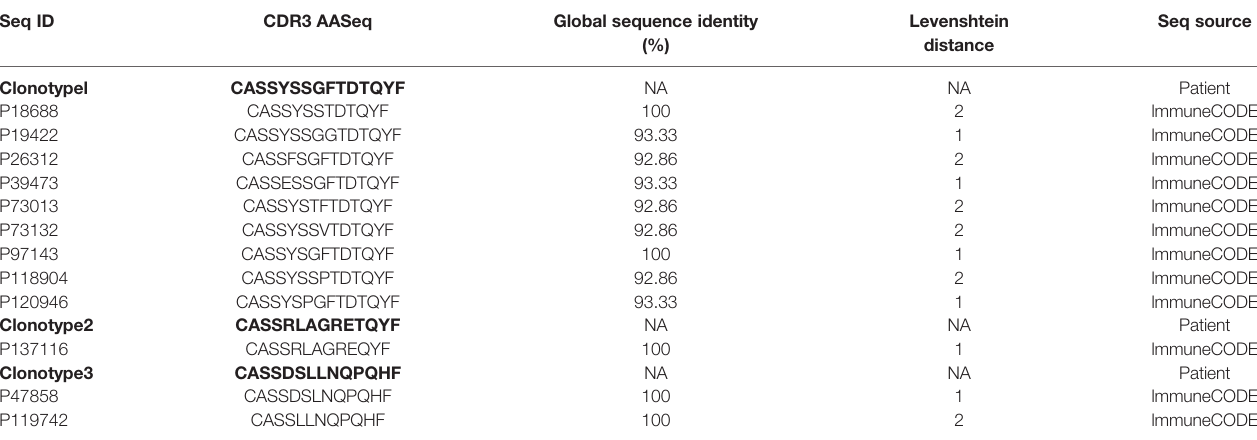
TABLE 1 | Similarity-based matches of TCR sequences from patient ’ s dominant clonotypes with validated SARS-CoV-2-speci fi c TCR sequences. Seq ID CDR3 AASeq Global sequence identity